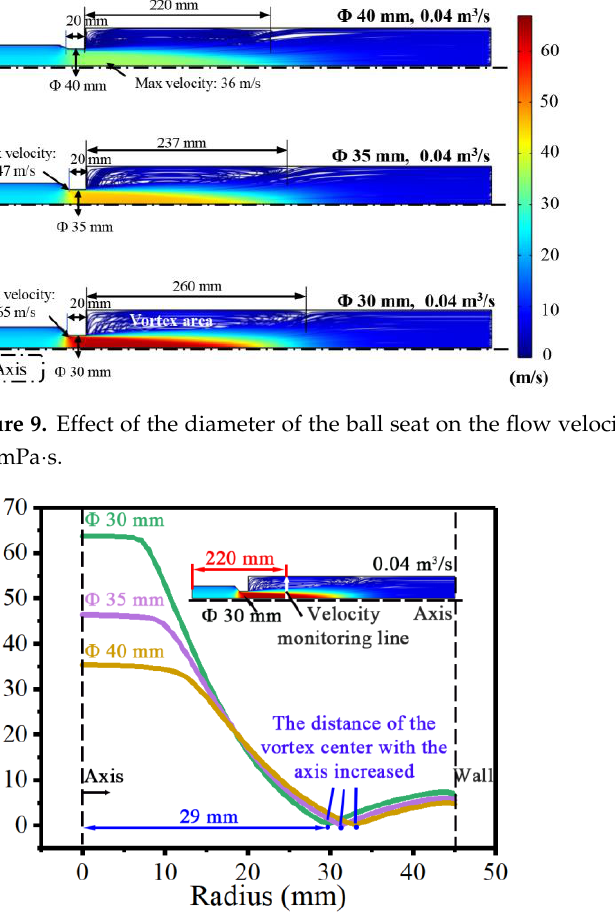
Figure 10. Velocity distributions at the monitoring line for ball seats with different diameters; the fluid viscosity was set as 100 mPa·s.